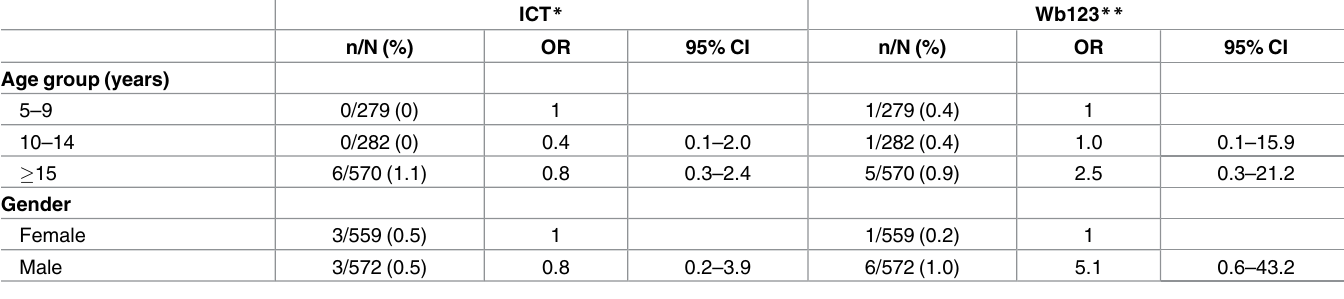
(Table 2). None of the antigenemia positive participants were Wb123 positive. The age range were no significant associations between demographic characteristics and LF antigenemia or Wb123 prevalence (Table 3). Table 3. Prevalence of lymphatic filariasis positive results by age and gender, Ke´dougou Region, using two diagnostic